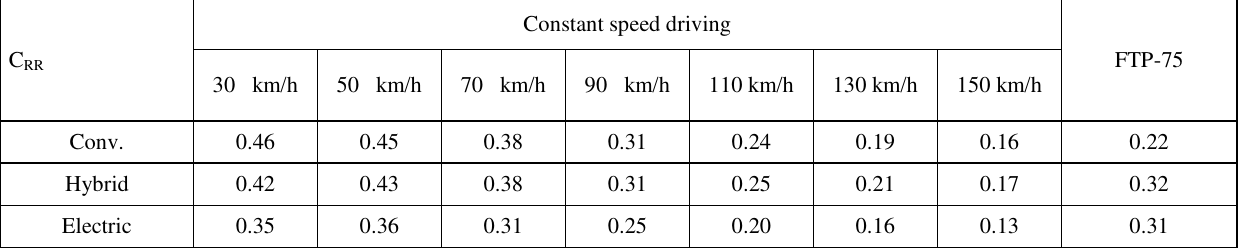
Table 4. Rolling Resistance Impact Factor for conventional, hybrid and electric